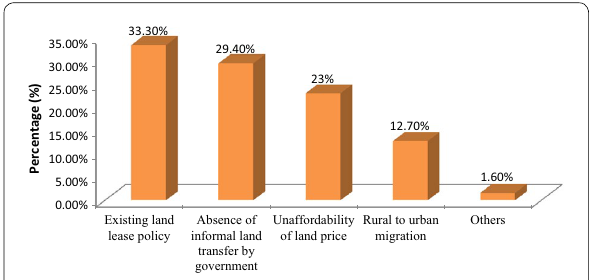
Fig. 6 The driving factors for informal settlement (Source: Field Survey 2018)